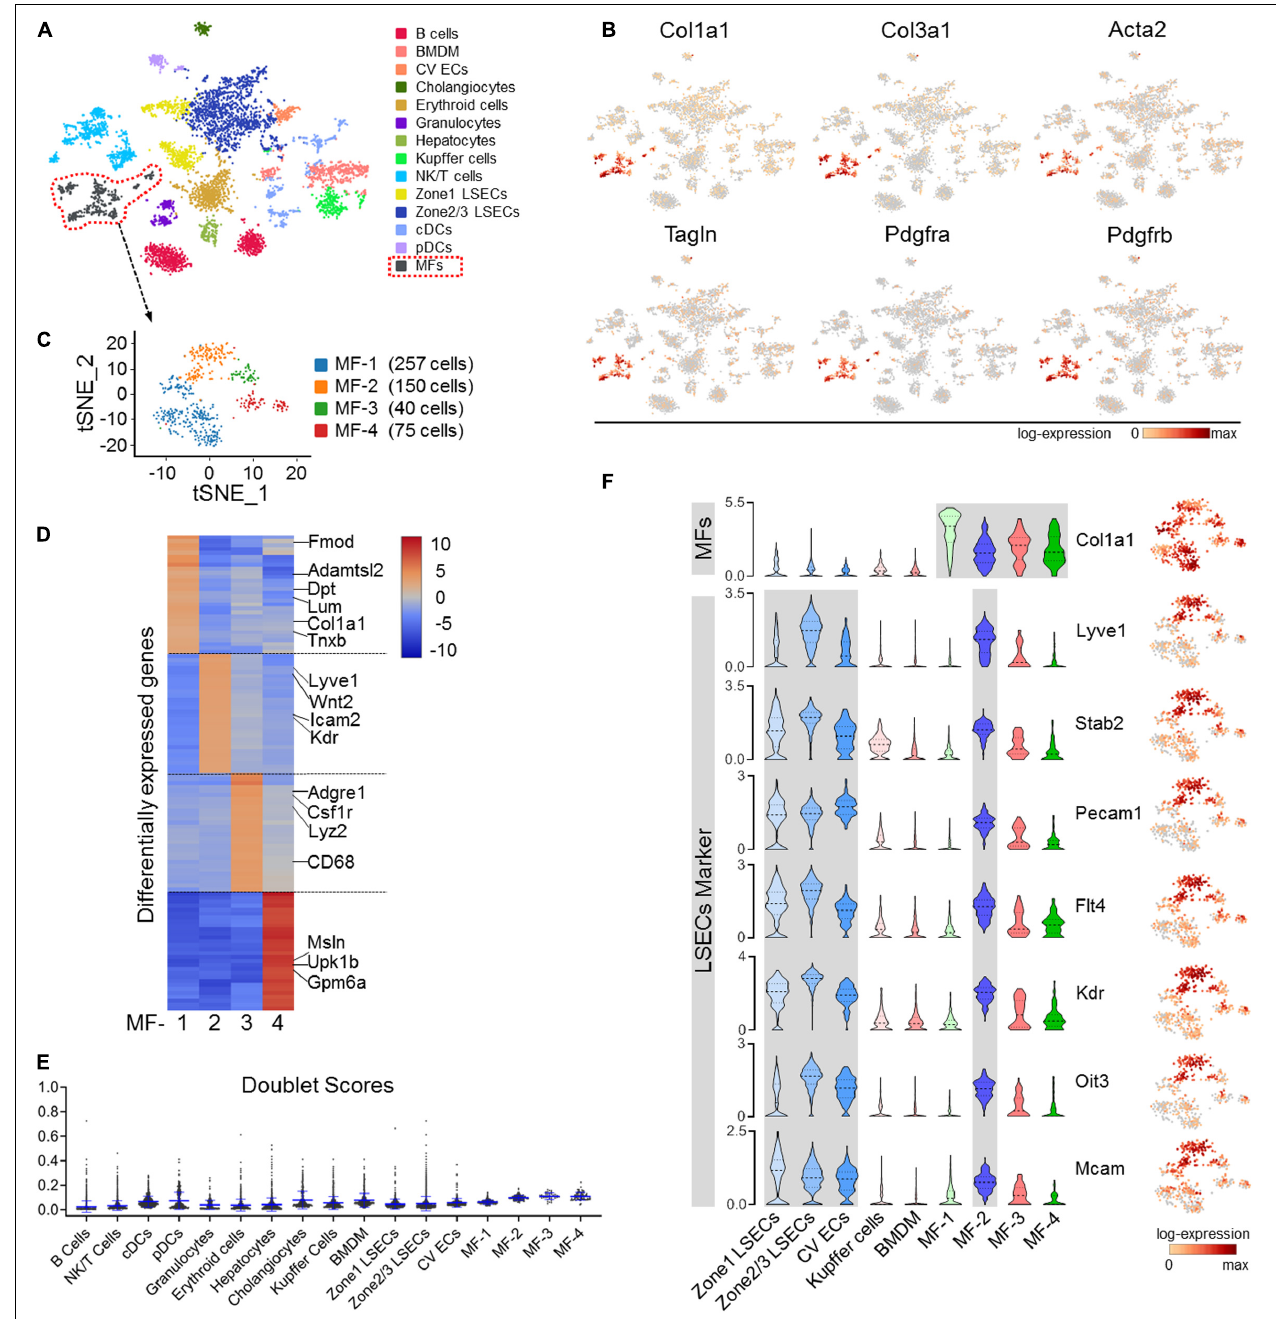
FIGURE 1 | scRNA-seq of NPCs in CCl 4 -induced liver fibrosis. (A) Clustering of 6,437 cells (mean number of genes per cell = 1,768) from the liver NPCs of a CCl 4 -treated male mouse. (B) The expression of representative MF marker genes, including Col1a1, Col3a1, Acta2 ( α -SMA), Tagln (SM22), Pdgfra, and Pdgfrb, in the population (marked with dotted lines in red) was visualized by gene tSNE. (C) The MF population in (A) was further clustered into four subsets and visualized by gene tSNE. (D) The top 30 differentially expressed genes in the four MF subpopulations are illustrated by heat map. (E) Cell doublet scores of the fibrotic-NPCs per cluster. (F) Individual gene tSNE and violin plots are used to show the expression of MF marker Col1a1 and LSEC markers Lyve1, Stab2, Pecam1, Flt4, Kdr, Oit3, and Mcam across different cell types. The y -axis is the log-scale normalized read count.